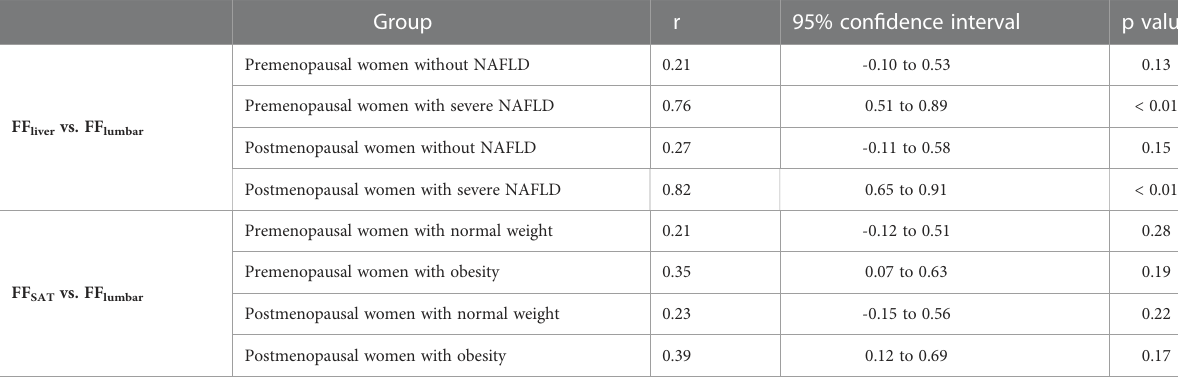
TABLE 4 The correlation coef fi cients between the FF liver , FF SAT , and FF lumbar .